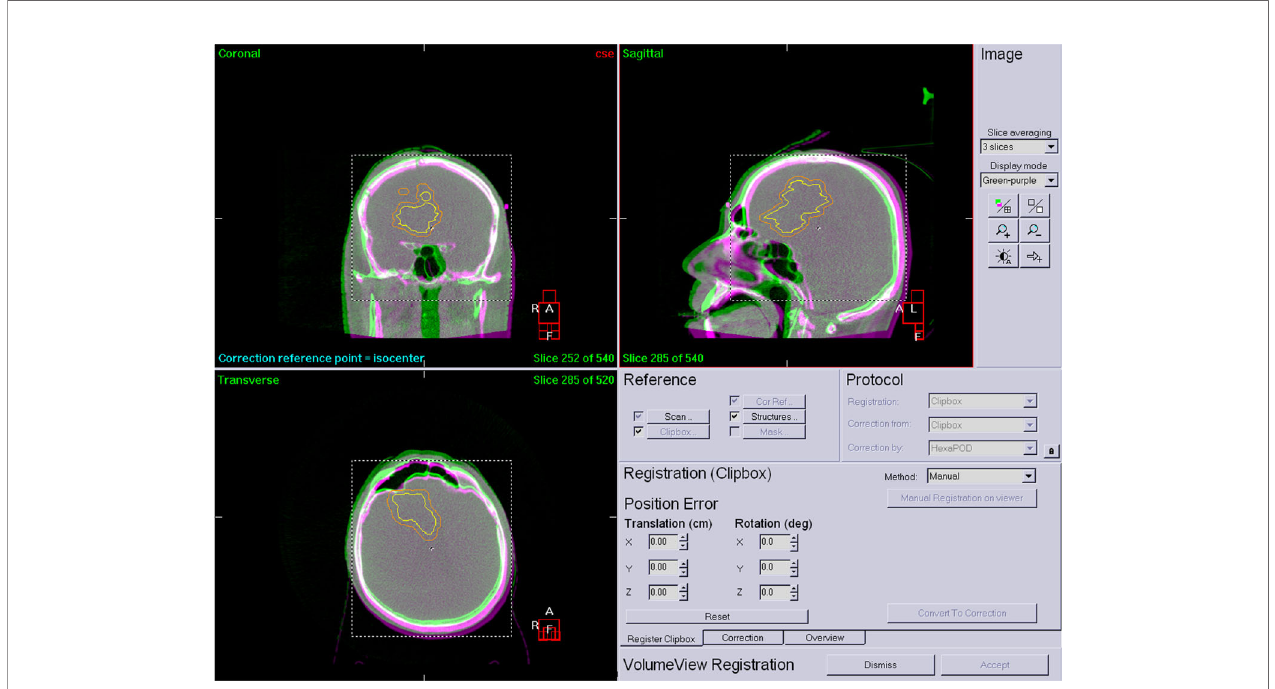
FIGURE 1 | Pre-treatment HR